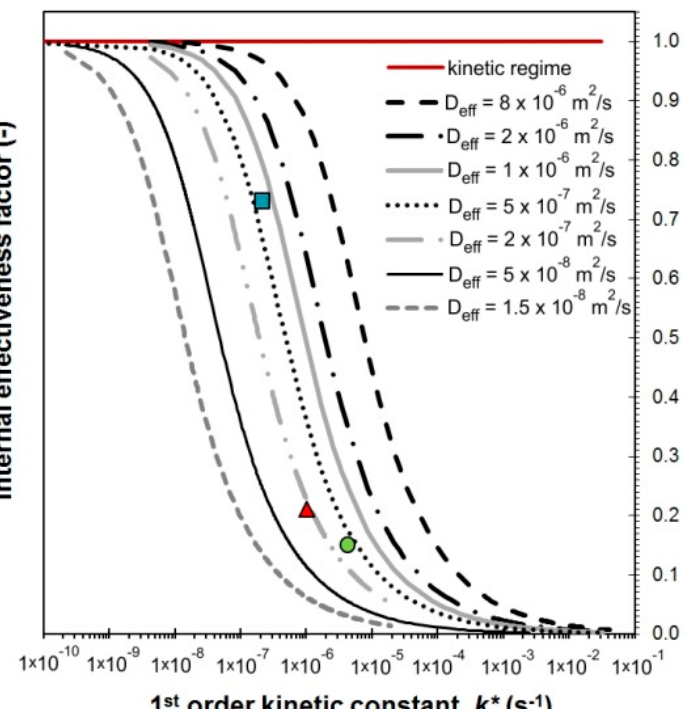
Figure 7. Dependence of N 2 O conversion on alkali metal loading. Conditions: 1000 ppm N 2 O + 5 mol% O 2 + 2 mol% H 2 O in N 2 . Figure 8. Dependence of internal effectiveness factor on the intrinsic 1 st order kinetic constant for different values of effective diffusion coefficients. Calculated for tablets 5.1 mm × 5.1 mm. K/Co 4 MnAlO x -industry; Cs/Co 4 MnAlO x -industry; Cs/Co 3 O 4 -industry. Table 4. Diffusion coefficients and tortuosity determined for commercially prepared